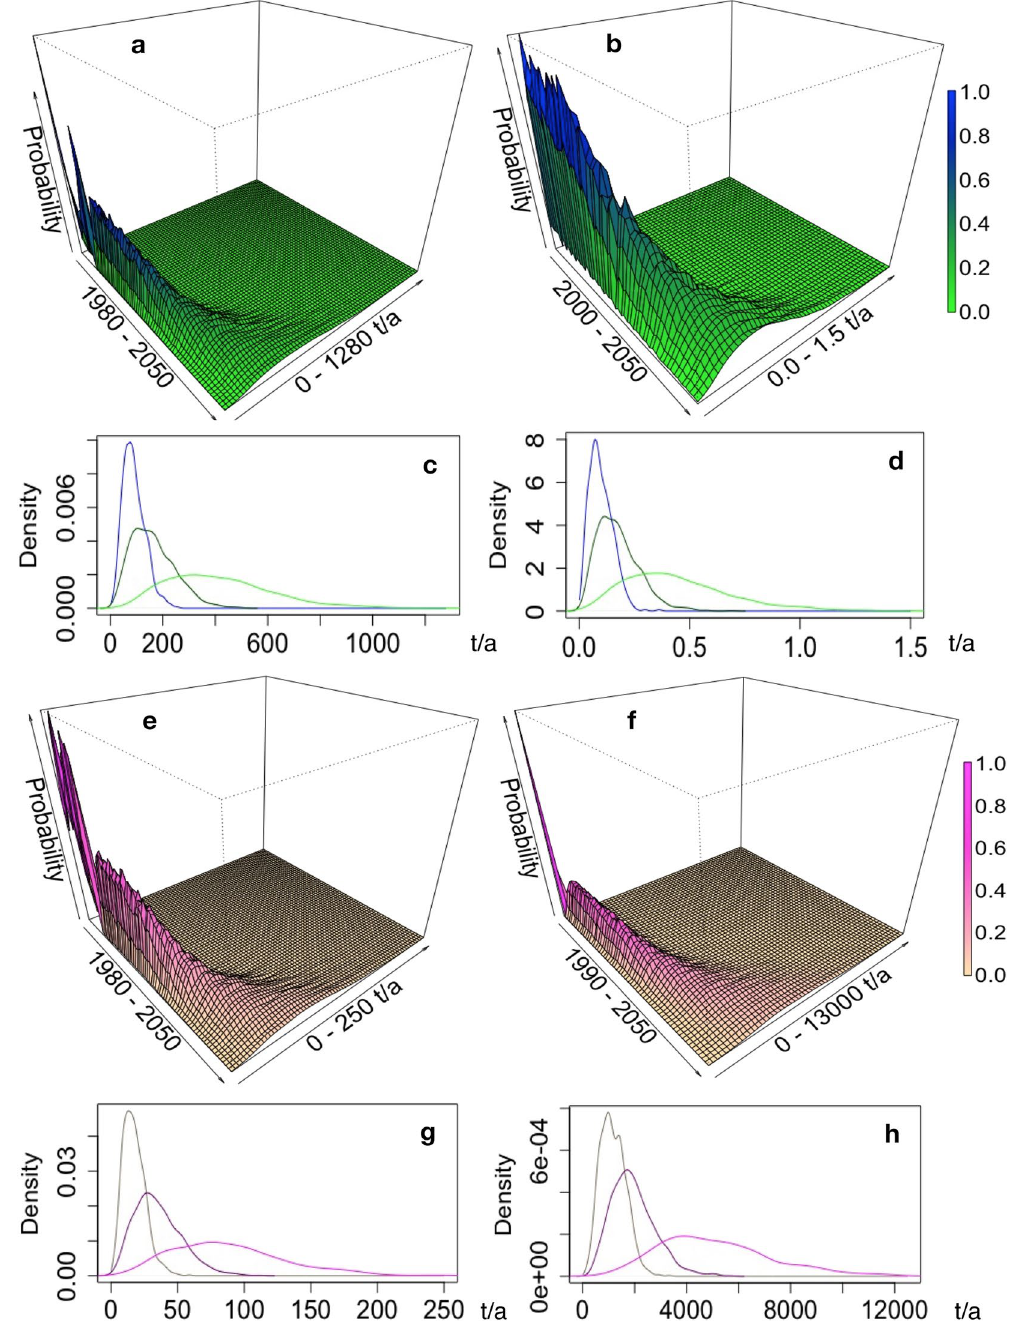
Figure 2. CeO 2 -ENM released into natural (waters, soils, air) and technical compartments (landfills, recycling, waste incineration, and sewage treatment). The former release is shown in the Figures ( a – d ), the latter in the Figures ( e – h ). The left side ( a , c , e , g ) shows ENM released during product uses. The right side ( b , d , f , h ) represents release during ENM products’ end-of-life phase. The corresponding relative density curves ( c taken from a , d taken from b , g taken from e , h taken from f ) represent, from left to right, outputs for the years 2017, 2030, and 2050. Shown are the whole ranges (range with some probability) of the stochastic modeling. Scenarios that theoretically run all ENM applications simultaneously at the lowest, or, in another scenario, at the highest ENM production, use and environmental release are not considered